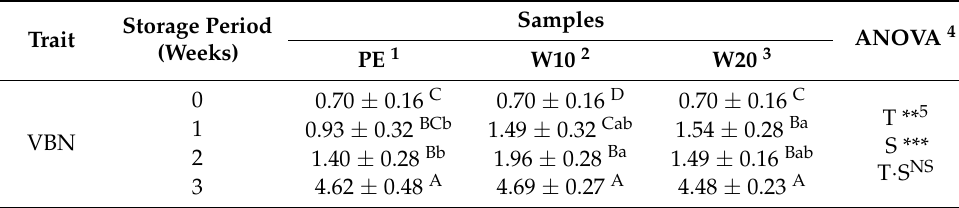
Table 3. Volatile basic nitrogen concentration (mg%) of sausages stored in the PE and biodegradable containers manufactured with walnut shell